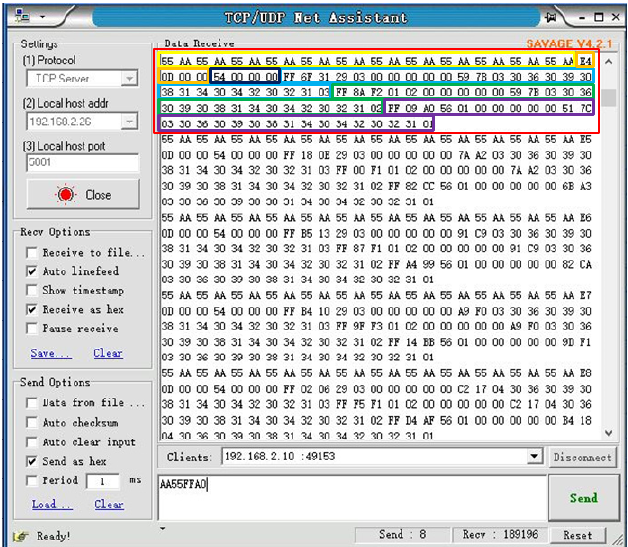
Figure 6. Link data read by the host computer.